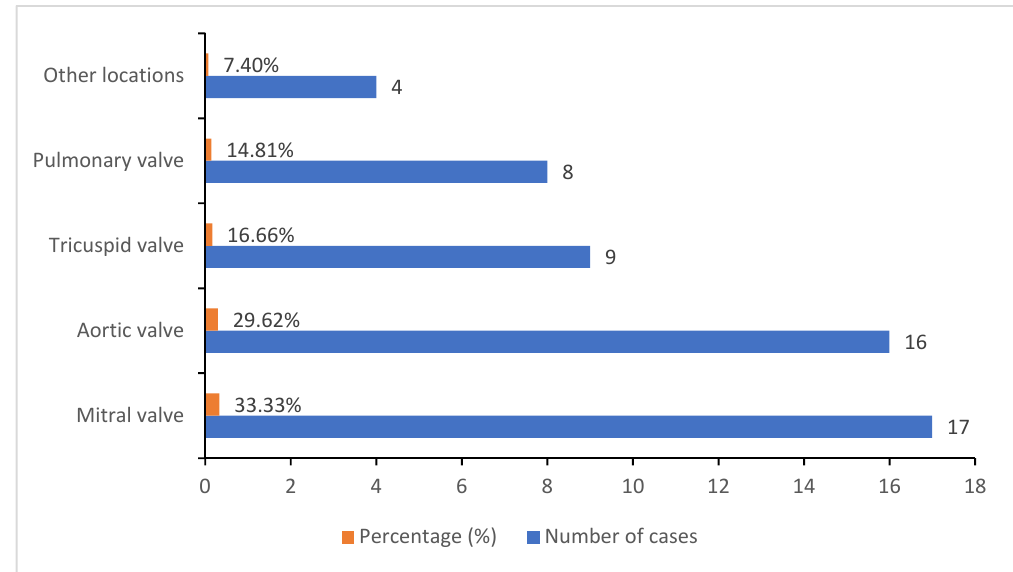
Figure 2. Echocardiographic distribution of valve injuries illustrated by percentages and the corresponding number of cases.